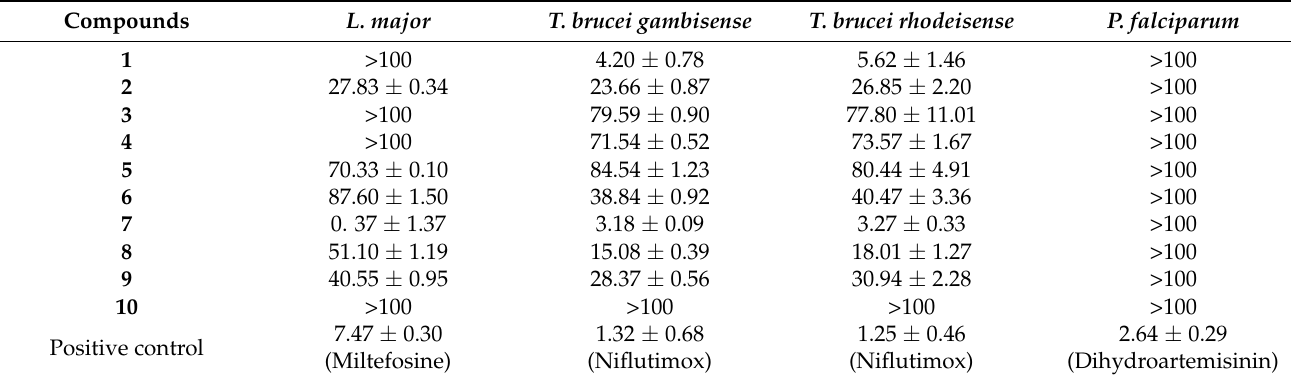
Table 3. IC 50 of the isolated compounds against parasites (Mean ± SE, µ g/mL, n = 3) . Compounds L.